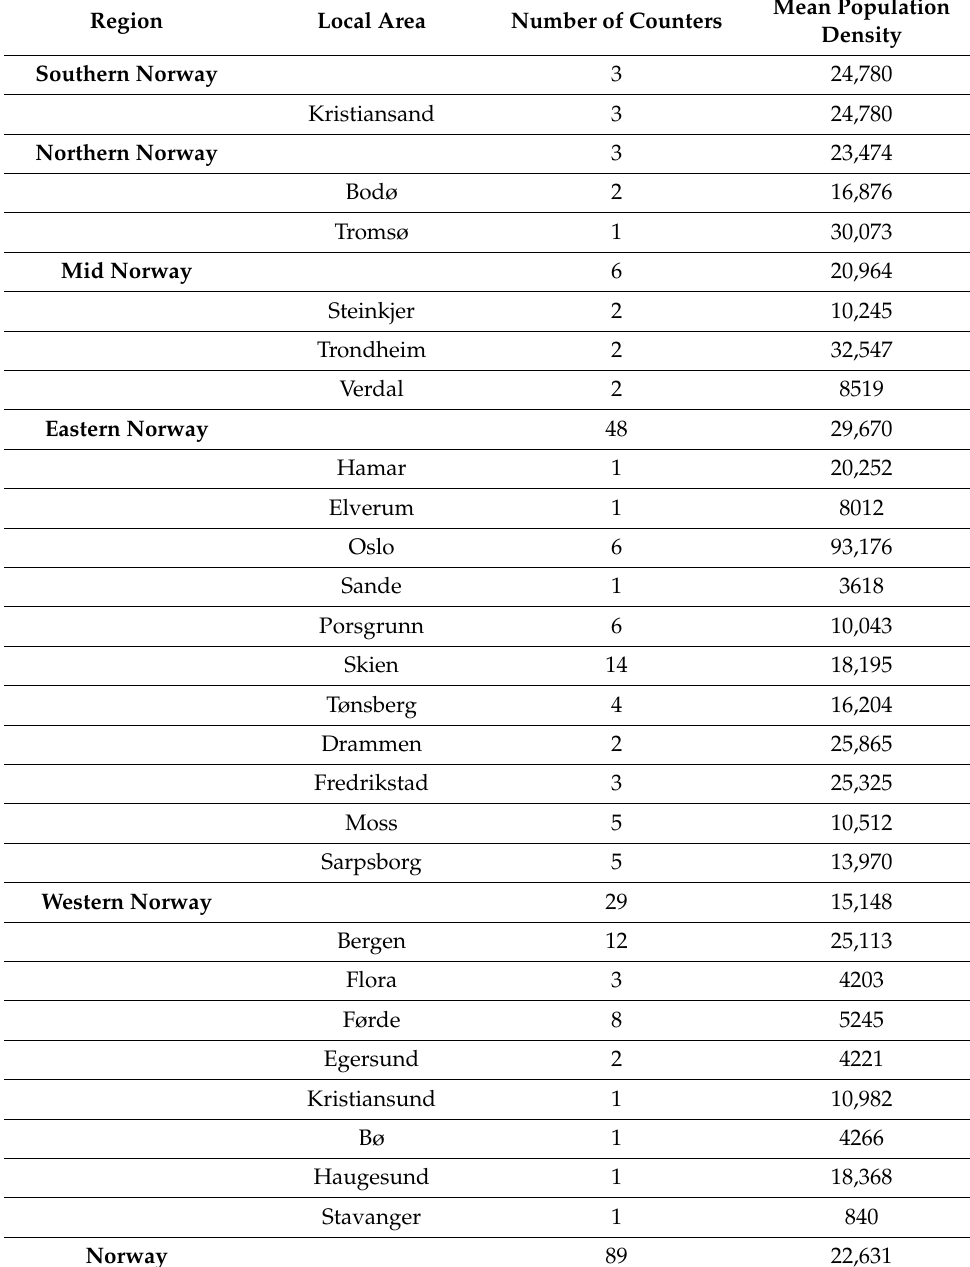
Table 1. Number of counters and population density at the local and regional